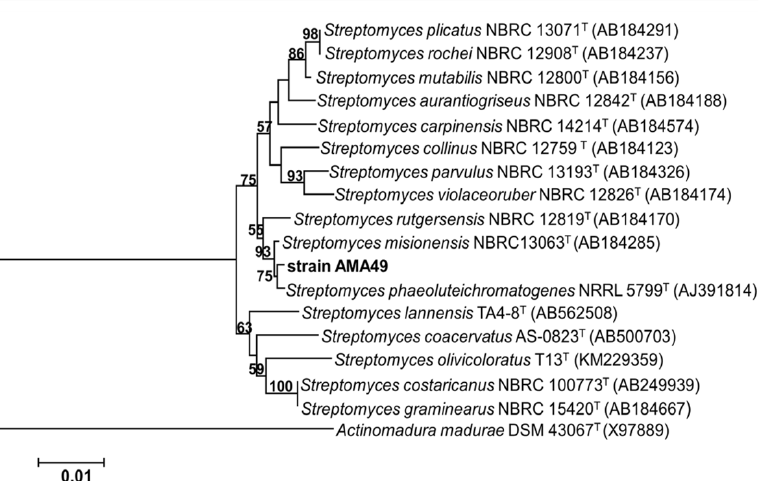
Fig. 3. Phylogentic tree of Streptomyces sp. AMA49 based on 16S rDNA sequecnes. The number on each branch represents bootstrap values ( ≥ 50%) from Neighbor-joining support with 1000 replications. The scale bar indicates 1% estimated sequence divergence. Actinomadura madurae X97889 was used as root of